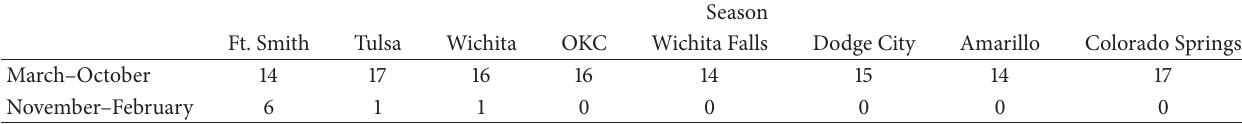
Table 7: Number of events occurring during the warm season (March–October) and cold season (November to